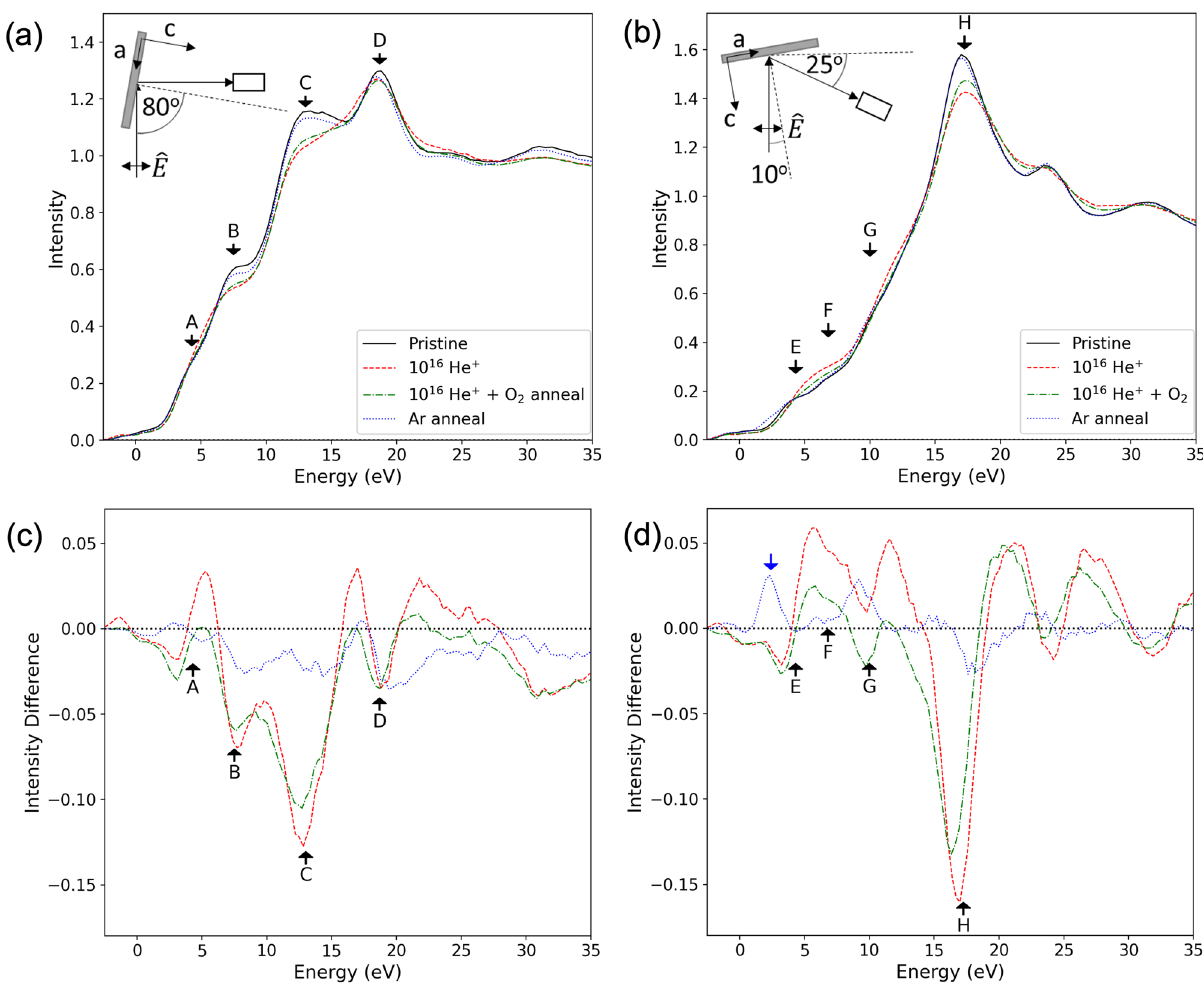
Fig. 5 Comparison of XANES spectra for pristine, Ar-annealed, He + -irradiated and post-irradiation oxygen-annealed coated conductor samples. a , b Show spectra for angles of incidence of 80° ( ^ E jj c ) and 10° ( ^ E jj a / b ), respectively. c , d Give the corresponding difference spectra, relative to the pristine sample. An additional peak in the ^ E jj a = b spectrum of the Ar-annealed sample is indicated with a blue